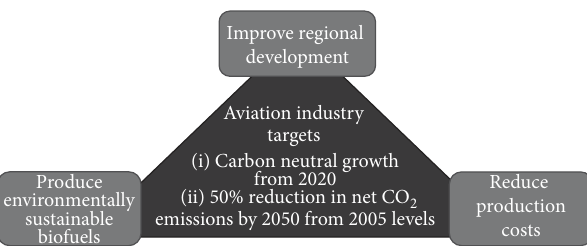
Figure 2: Strategic objectives for 2050 for the aviation industry regarding jet fuel substitution by biofuels.